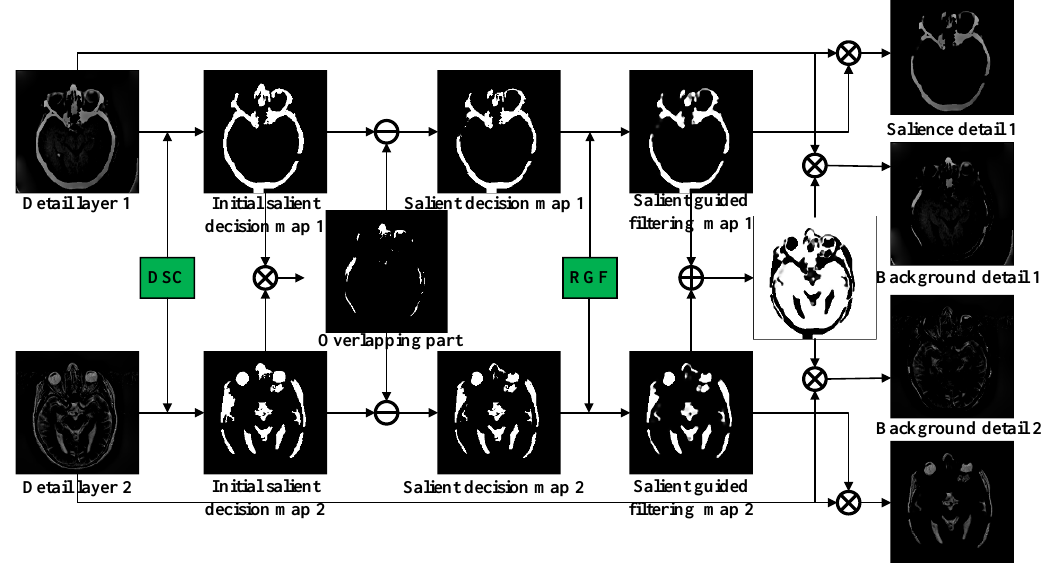
Figure 3. Deformed smoothness constraint–rolling guidance filter (DSC-RGF) algorithm.